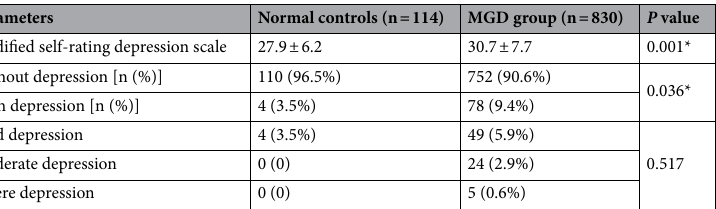
Table 4. Evaluation of depression symptom in normal controls and MGD group. Depression was assessed using the self-rating scale and definite depression was defined as having a depression score of 40 or higher. The severity of depression was rated as mild, 40–50 scores; moderate, 50–60 scores; and severe, above 60 scores. *P < 0.05 was considered statistically significant.